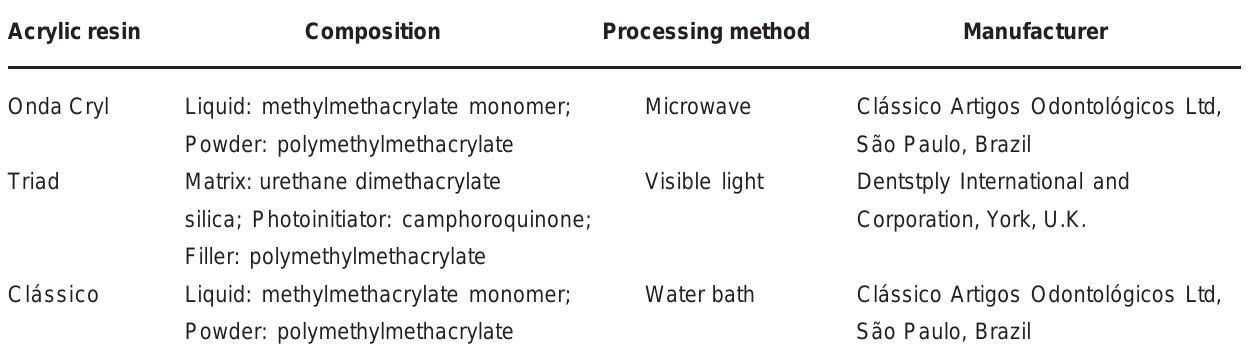
TABLE 1- Composition, processing method, and manufacturer of acrylic